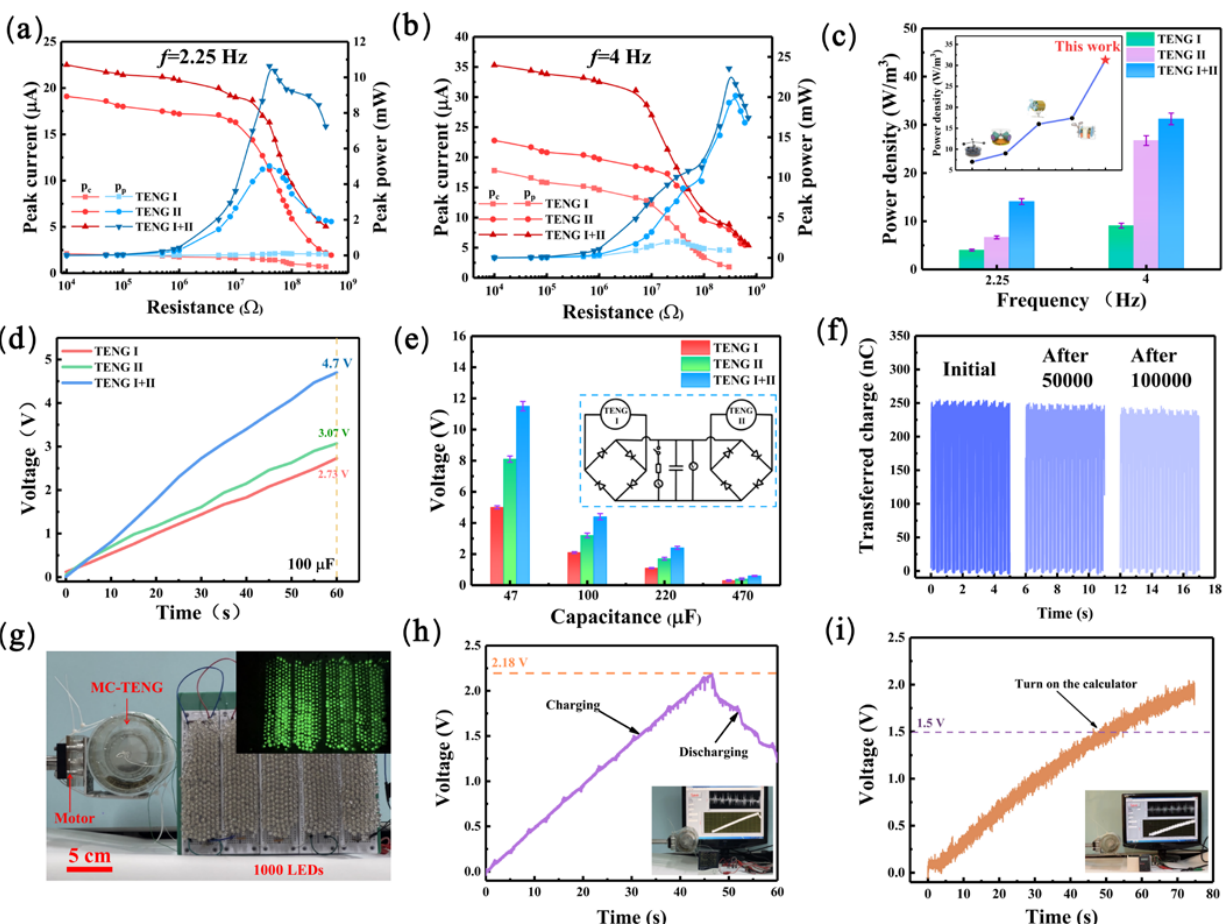
Figure 5. The electrical output performance and demonstration of the MC-TENG driven by a linear motor. ( a , b ) Output current, peak power of the MC-TENG with resistance driven by a linear motor. ( c ) The power density of the MC-TENG at different frequencies. ( d ) Time comparison of the MC-TENG to charge a 100 µ F capacitor. ( e ) The charging of different capacitors by the MC-TENG. ( f ) The amount of transferred charge after 100,000 cycles. ( g ) Photograph of the MC-TENG powering 1000 LEDs. Demonstration of the MC-TENG powering a temperature/humidity meter ( h ) and a calculator ( i ).